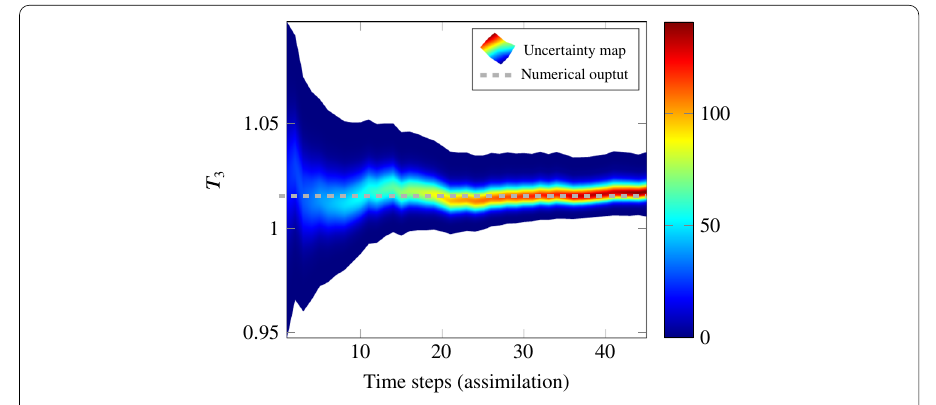
Fig. 14 Prediction of temperature T 3 at physical time step τ ∗ = 45 after each assimilation time step t i ,i ∈ { 1 , ... , 45 } - Case